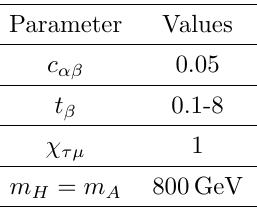
Figure 5 . R quark at NLO in QCD as a function of the charged scalar boson mass for t (cid:12) =2, 5, 10. Solid line represents the experimental central value while red crosses indicate the theoretical SM central value. Green and yellow bands stand for 1 (cid:27) and 2 (cid:27) , respectively. R quark is de(cid:12)ned in the main text.